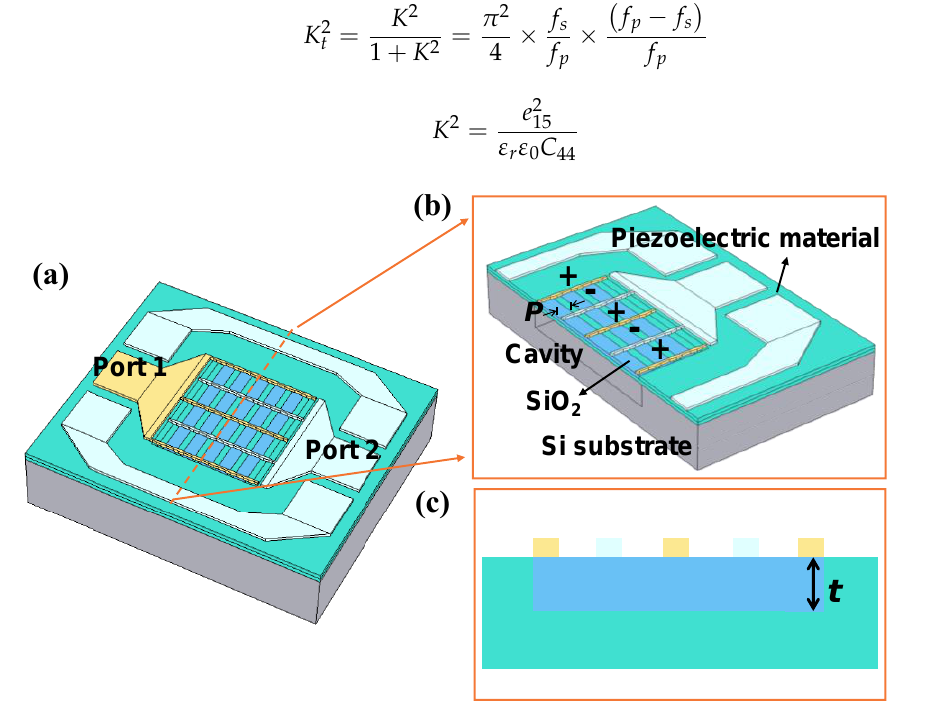
Figure 3. ( a ) Schematic drawing of laterally excited bulk acoustic wave resonator using composite piezoelectric material. ( b ) Sectional view of the resonator cut across the dashed line. ( c ) 2D schematic of the effective working area along the dashed line.